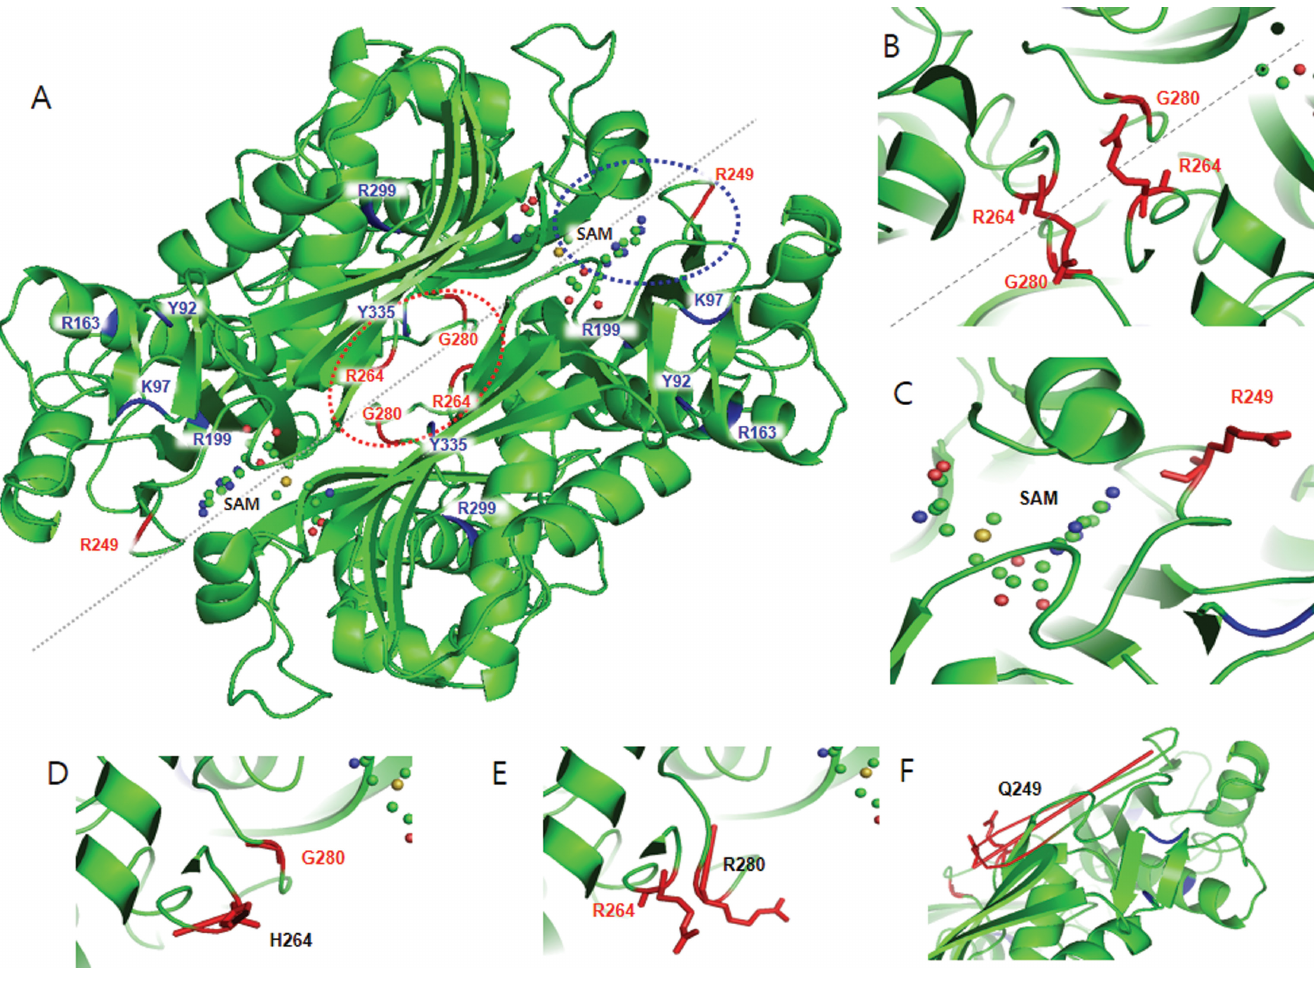
Figure 2. Crystal structure of the human MAT IA. (A) Monoallelic mutations (red color) are located on the dimer interface (red dotted circle) or SAM binding site (blue dotted circle), whereas biallelic mutations (blue color) are located distant from the dimer interface. (B) p.Gly280 and p.Arg264 are located on the dimeric interface, facing each other. (C) p.Arg249 is located on the SAM binding pocket as well as on the dimer interface. (D–F) Three missense mutations (p.Arg249Gln, p.Arg264His and p.Gly280Arg) are shown in black color with their structural